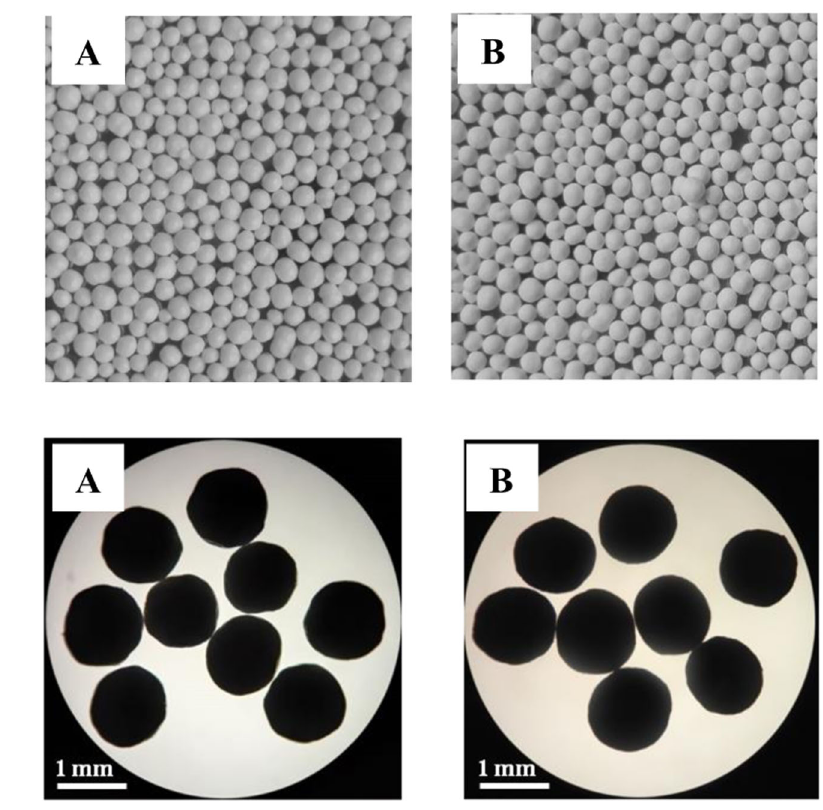
Fig. 5 Optical micrographs of the aspirin ( A ) and L-glutamate ( B ) drug-loaded pellets